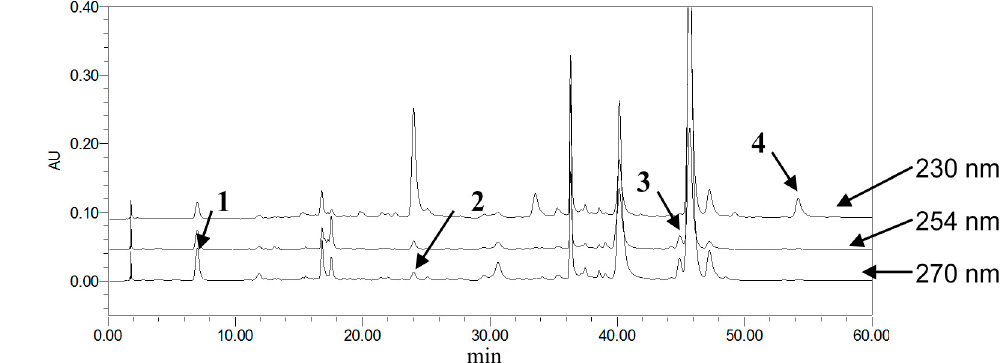
Figure 3. Stacked view of different detector wavelength HPLC chromatograms of GZFLW (from top to bottom: 230, 254, 270